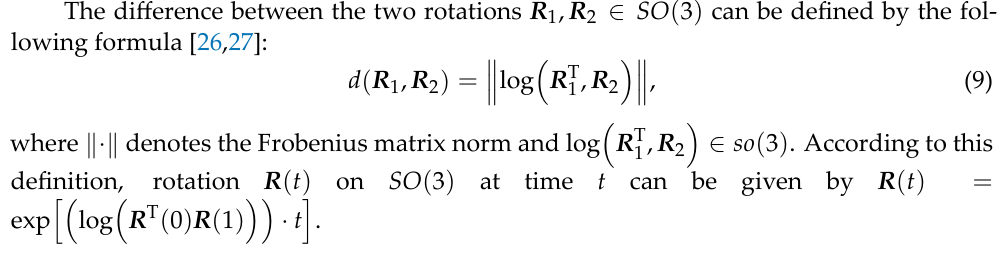
Figure 1. Schematic representation of the mathematical relation between the Lie algebra and the Lie